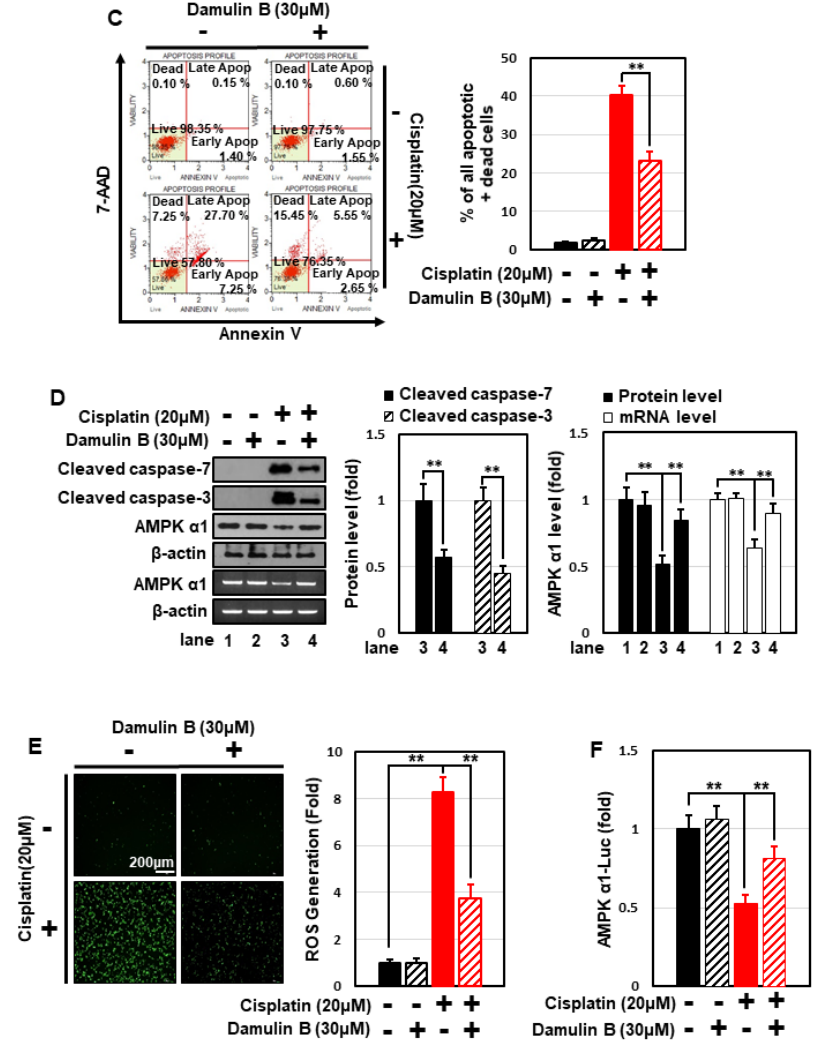
Figure 7. Damulin B protects HEK293 cells from cisplatin ‐ induced cytotoxicity. HEK293 cells were treated with the indicated concentration of damulin B or gypenoside XLVI or XVII in the presence or absence of cisplatin for 24 h, and then analyzed. ( A , B ) Cell viability assay; ( C ) apoptosis assay; ( D ) Western blotting and RT ‐ PCR analysis; ( E ), cellular ROS level; ( F ) luciferase assay. The results shown are representative of the three independent experiments. p ‐ value < 0.05 was considered statistically significant; individual p ‐ values (* p < 0.05; ** p < 0.01) are indicated in figures.